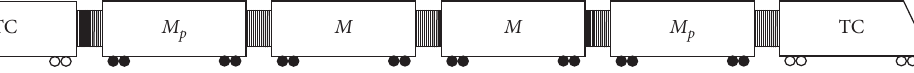
Figure 1: Structure diagram of the MTS.